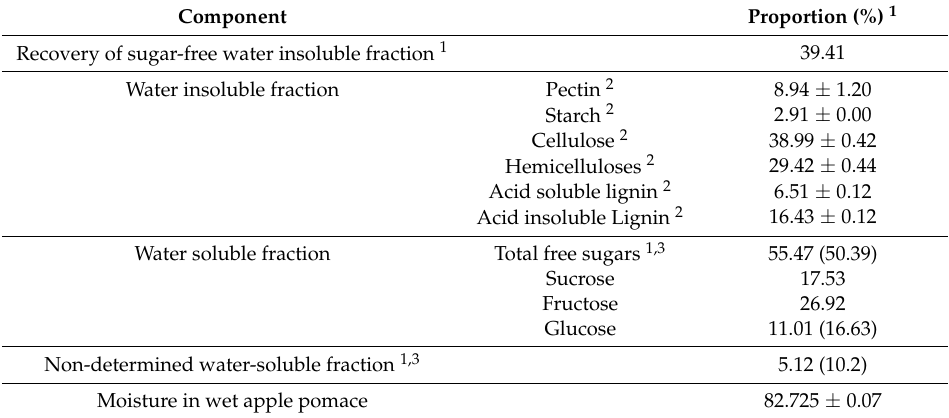
Table 1. Characterization of apple pomace. By washing of apple pomace, the free sugars and some other water-soluble components were removed, resulting in the sugar-free